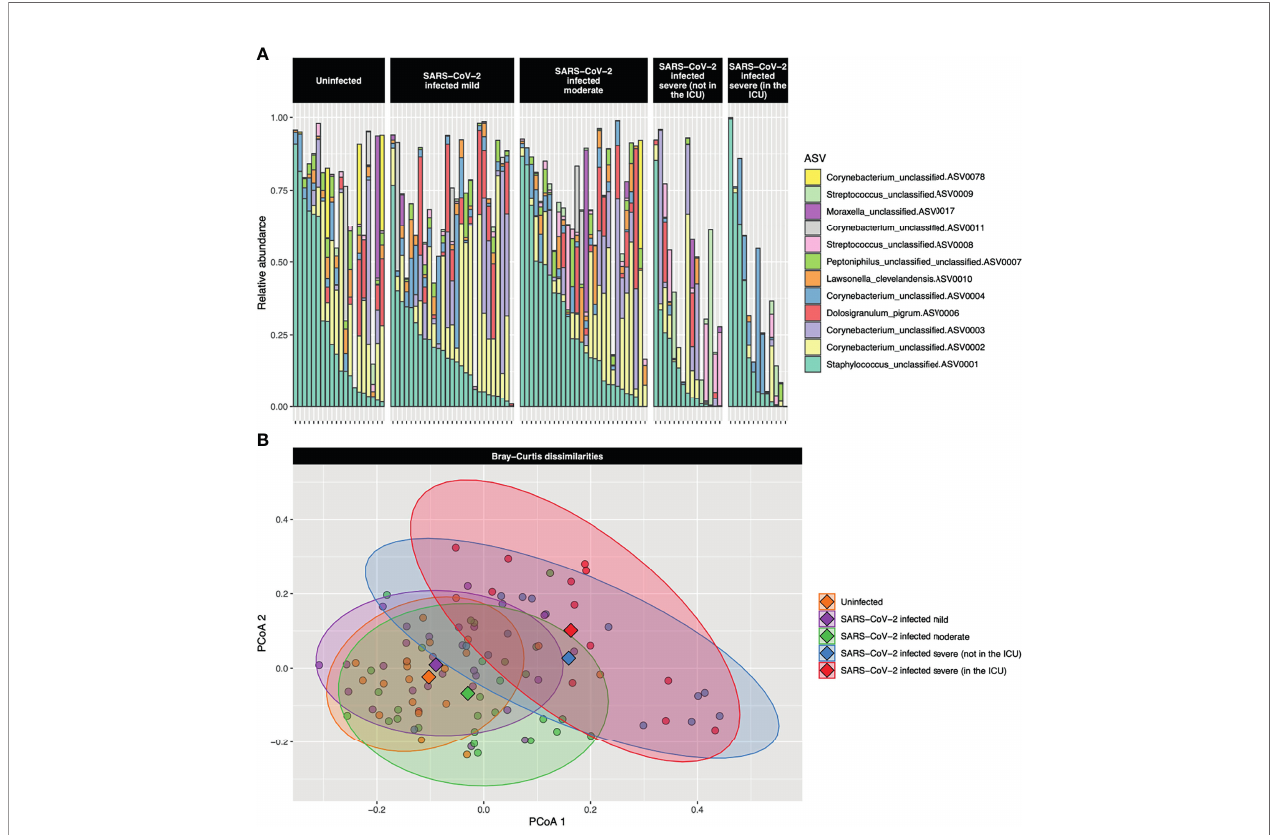
FIGURE 1 | (A) Stacked bar charts of the relative abundance of the 12 most abundant amplicon sequence variants (ASVs) are shown for each study participant. The most abundant ASV, Staphylococcus _unclassi fi ed.ASV0001, was abundant both in uninfected controls and participants with the full range of COVID-19 severities. The second most abundant ASV, Corynebacterium _unclassi fi ed.ASV0002, was highly abundant in uninfected control participants and those with mild-to- moderate COVID-19, but was of low abundance in those with severe or very severe COVID-19. (B) A principal coordinate analysis (PCoA) plot of the Bray – Curtis dissimilarities over the fi rst two axes is shown. Dots represent individual data points and diamonds show the centroids. The 90% con fi dence data ellipses are shown for each of the COVID-19 severity groups. Overall, microbial community composition was signi fi cantly dissimilar among the severity groups ( P <